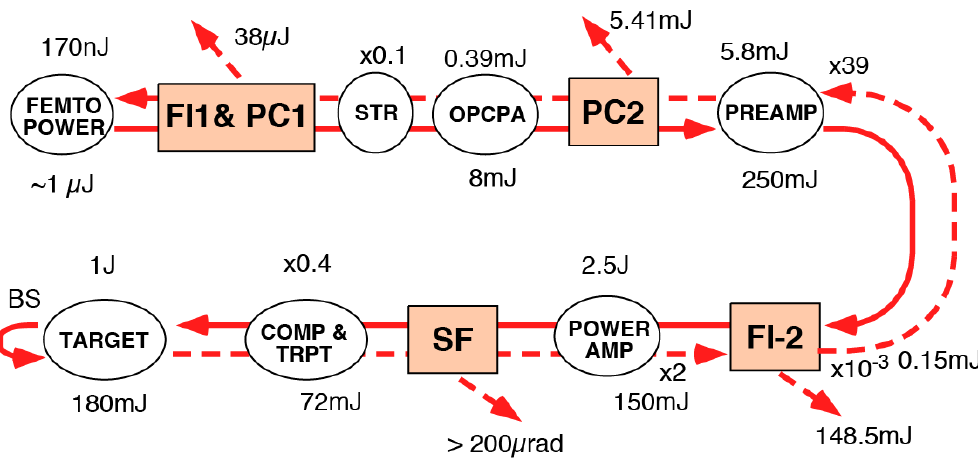
Figure 15. A schematic of head-on laser system. FI: Faraday isolator; PC: Pockels cell; SF: spatial filter; STR: pulse stretcher; COMP: pulse compressor; TRPT: laser transport. Typical energies in the laser chain and estimated energies of returning pulses are